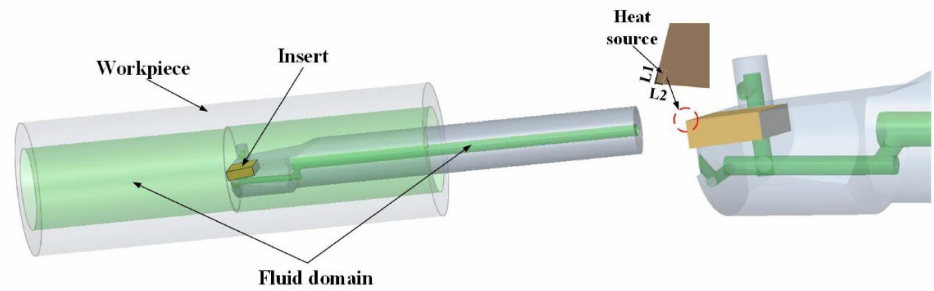
Figure 2. The geometric model of numerical simulation for the internal spray cooling turning